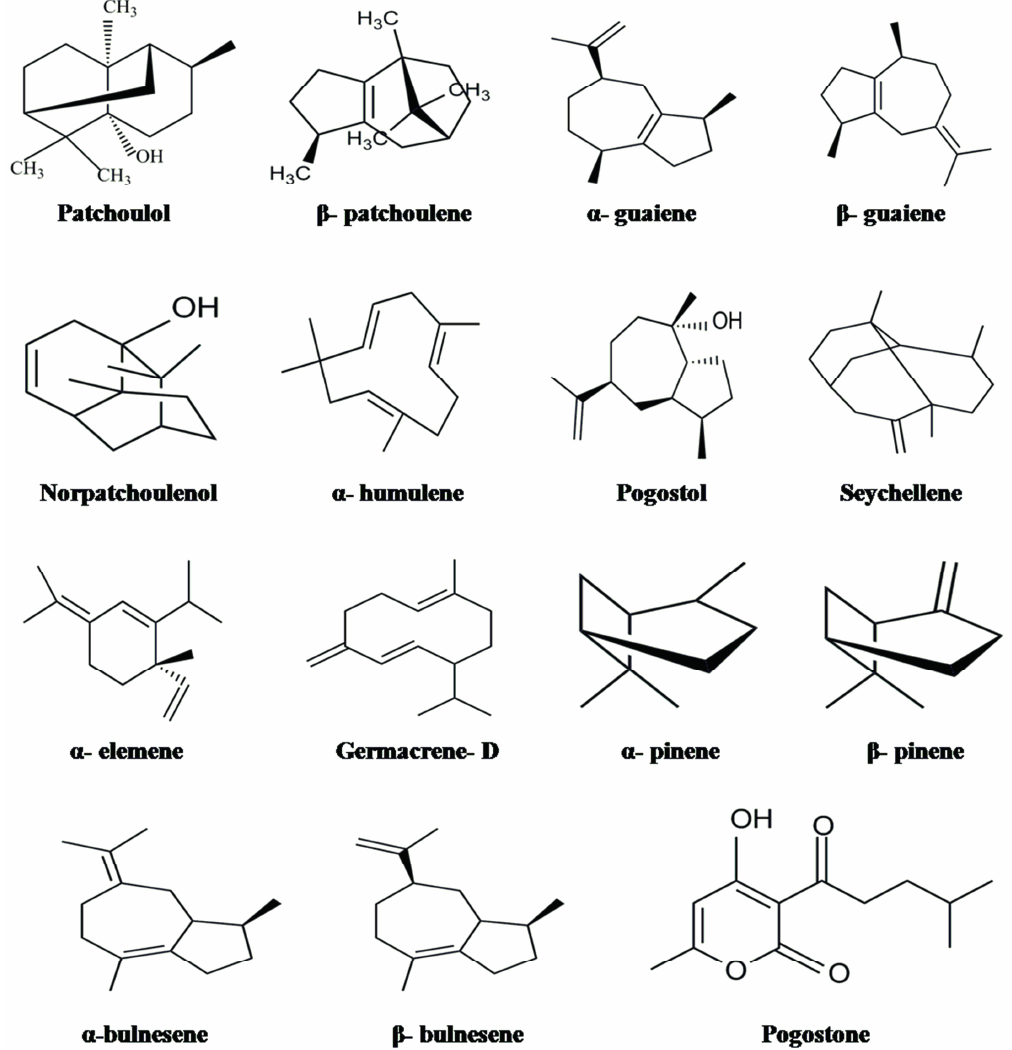
Figure 1. The structures of some of the volatile chemical